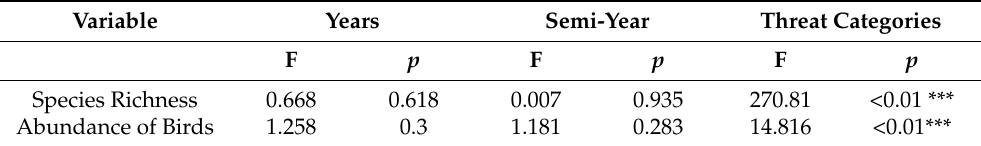
Table 3. Effects of years, semi-years and threat categories on species richness and abundance of birds.